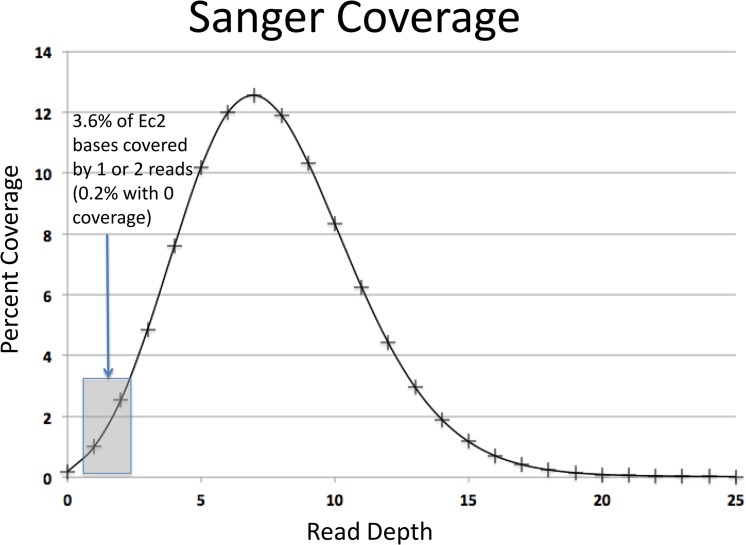
Depth of Sanger Read Coverage.A graph of depth of coverage for the mapped Sanger reads. The shaded gray box highlights the percentage of reads covered by one or two reads.